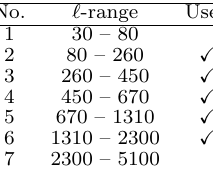
Figure 5. Measurements of the E-mode power spectra estimated from CFHTLenS data. Red points and red solid error bars indicate positive C (cid:96) , while blue triangles and dashed error bars refer to negative C (cid:96) . Solid black lines show the theoretical predictions for the best fit cosmology of (Joudaki et al. 2017). Gray shaded areas represent (cid:96) -bandpowers that have been discarded in this analysis. No. (cid:96) -range